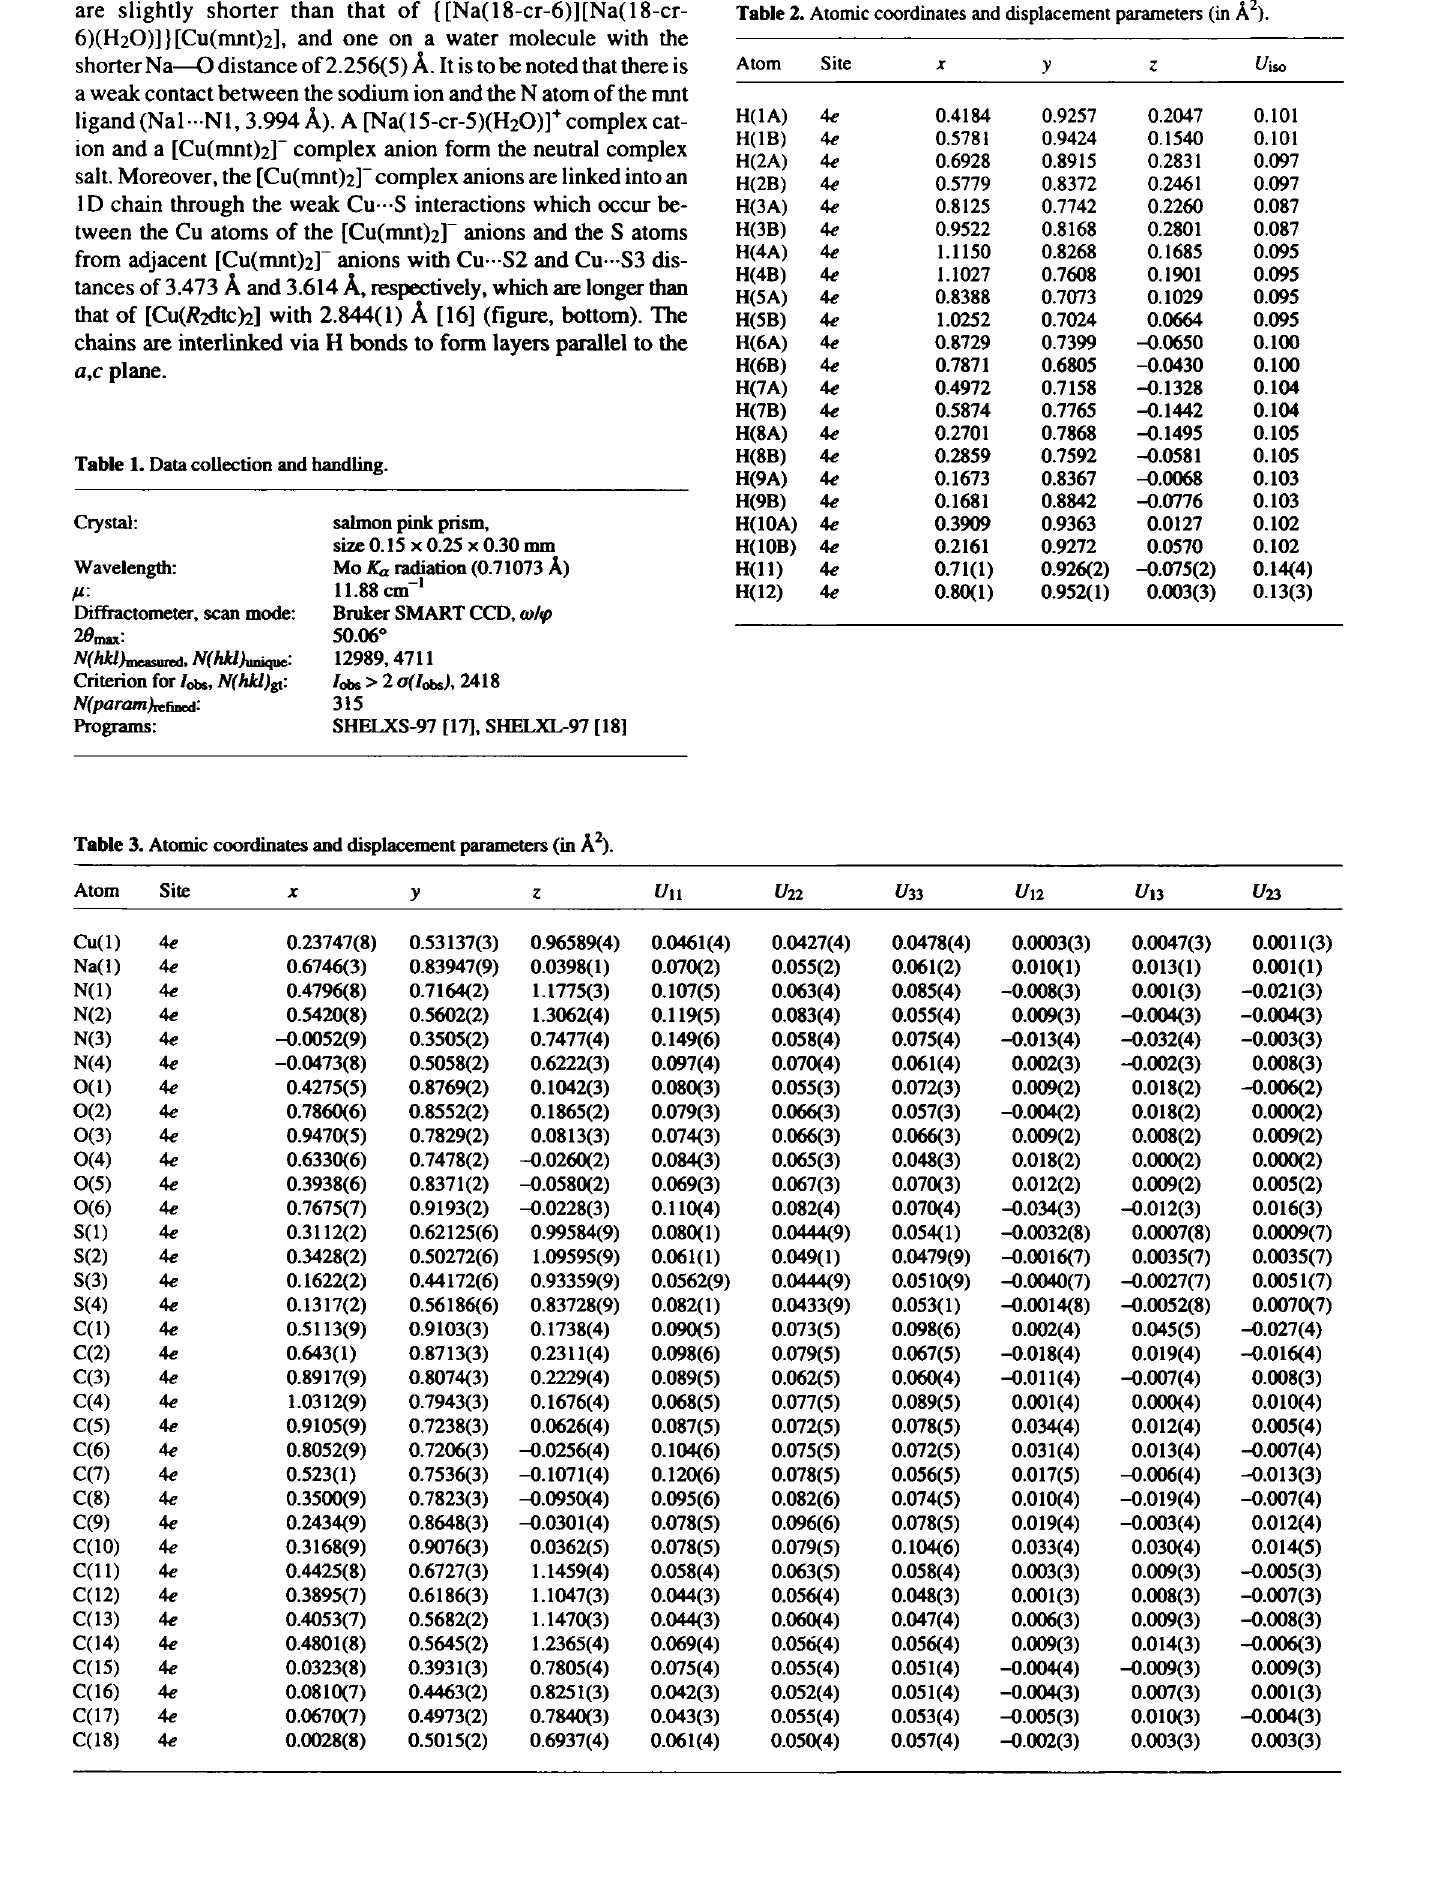
Table 2. Atomic coordinates and displacement parameters (in Ä 2 ).